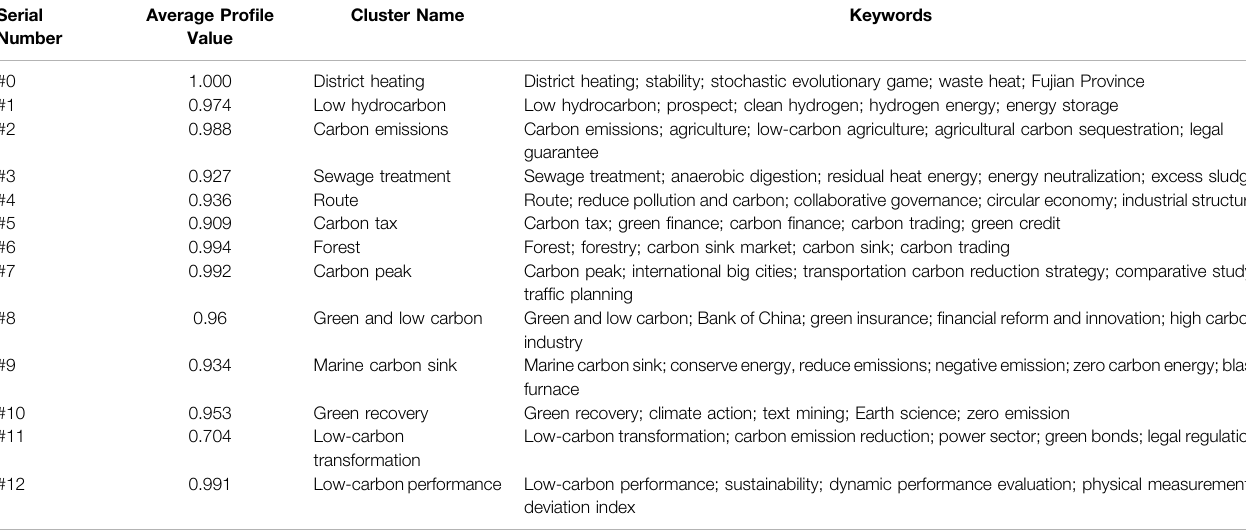
TABLE 1 | Carbon neutrality study of the top 13 keyword network co-emergence cluster table. Serial